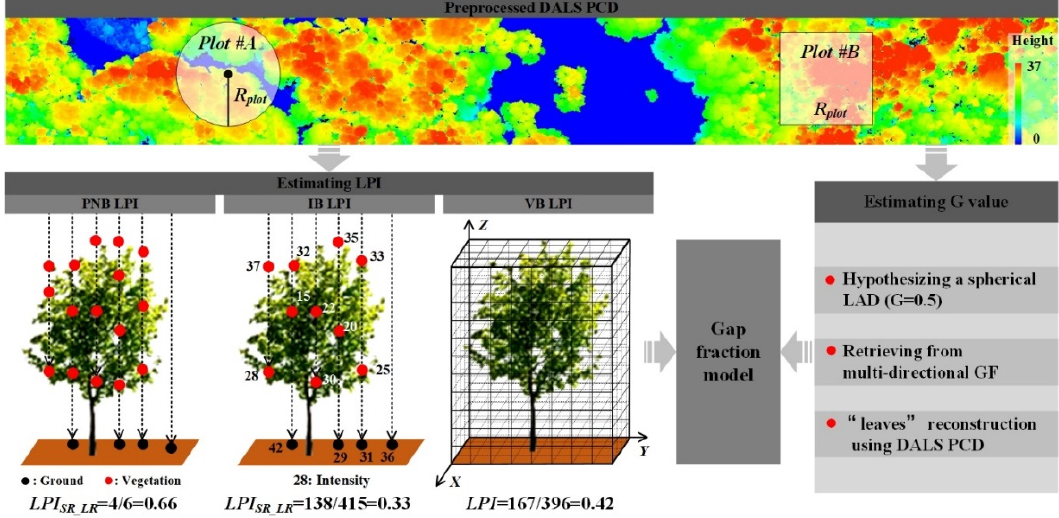
Figure 2. General pattern of retrieving LAI based on the gap fraction model.